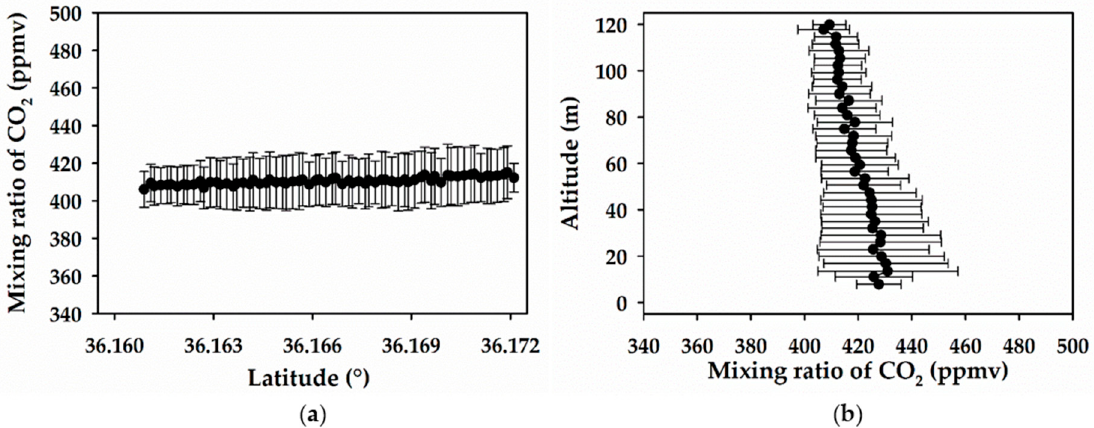
Figure 10. ( a ) The horizontal and ( b ) the vertical flight paths measuring the variable mixing ratio of CO 2 during the morning of 28 June, 2017 from 9:28 to 10:22 am (UTC–5 h).